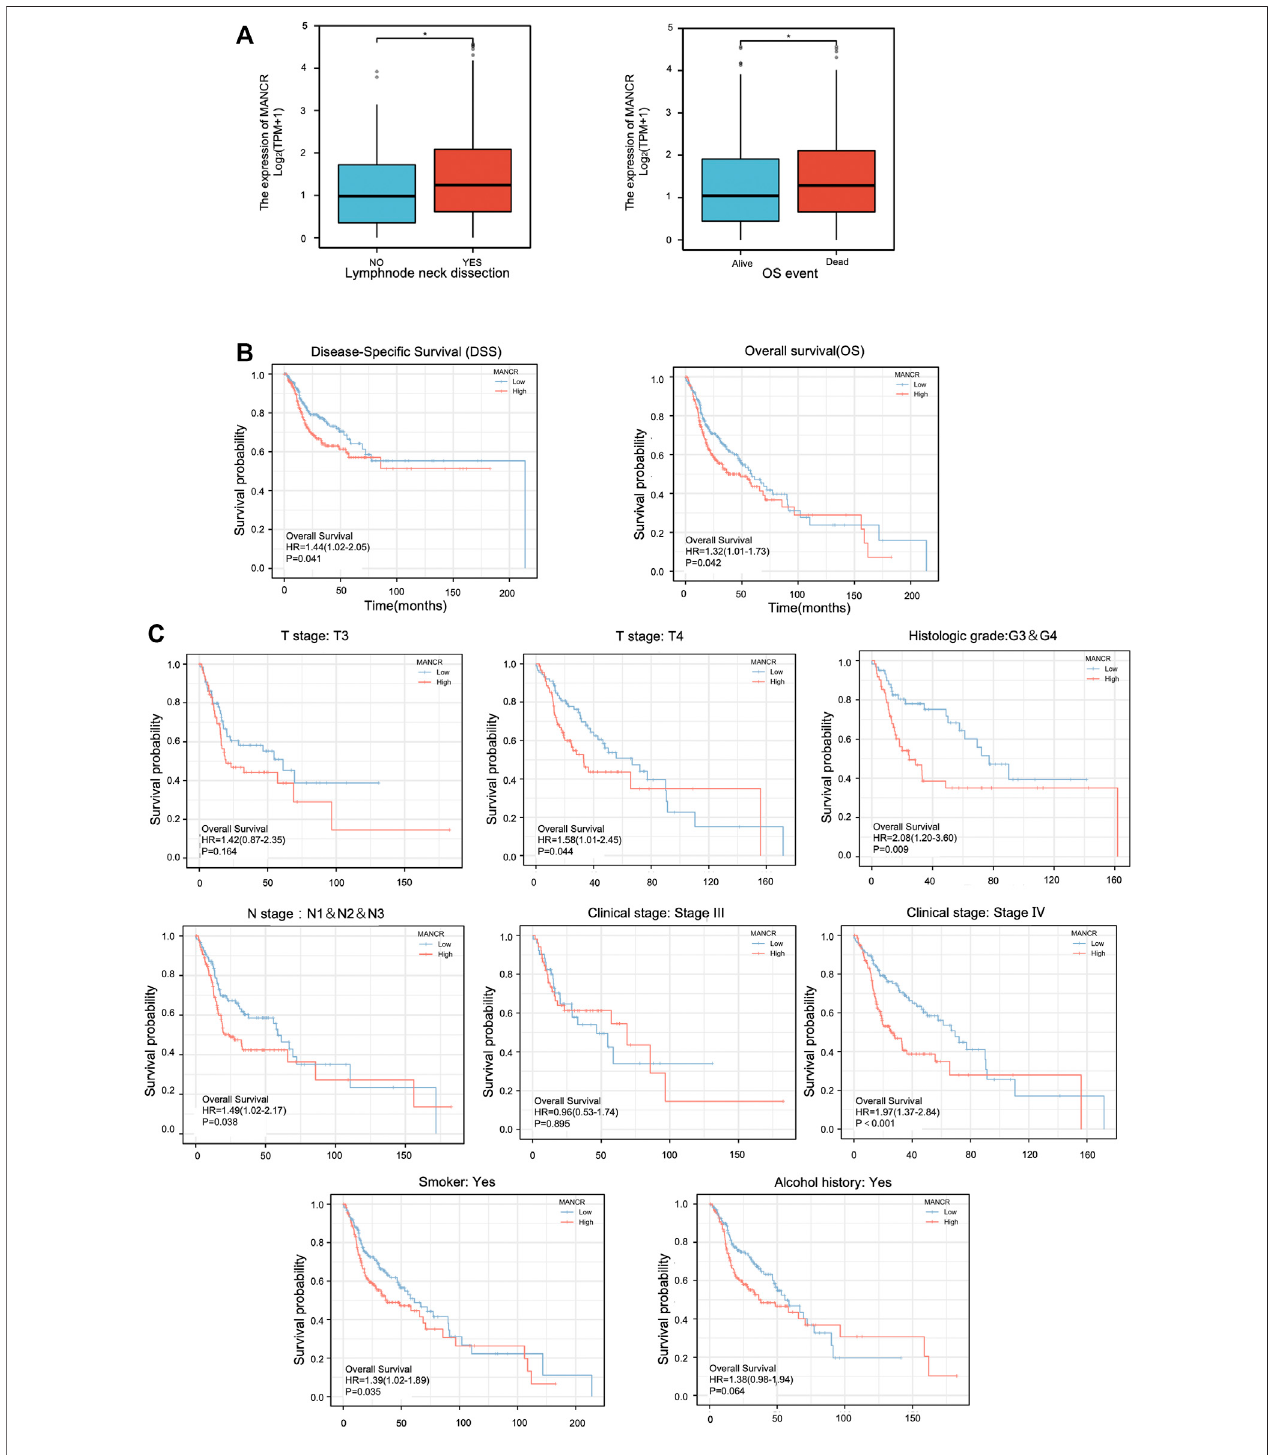
FIGURE 2 | MANCR expression and prognosis correlation in HNSCC: (A) high expression level of MANCR was associated with lymph node neck dissection and poor OS. (B) Kaplan – Meier curves showed the overall survival and disease-speci fi c survival in high- and low- MANCR expression of patient groups. (C) Subgroup analysis including the TN stage, clinical stage, histologic grade, smoking, and alcohol history. Data were shown as mean ± SD (* p < 0.05, ** p < 0.01, *** p < 0.001, and **** p < 0.0001).